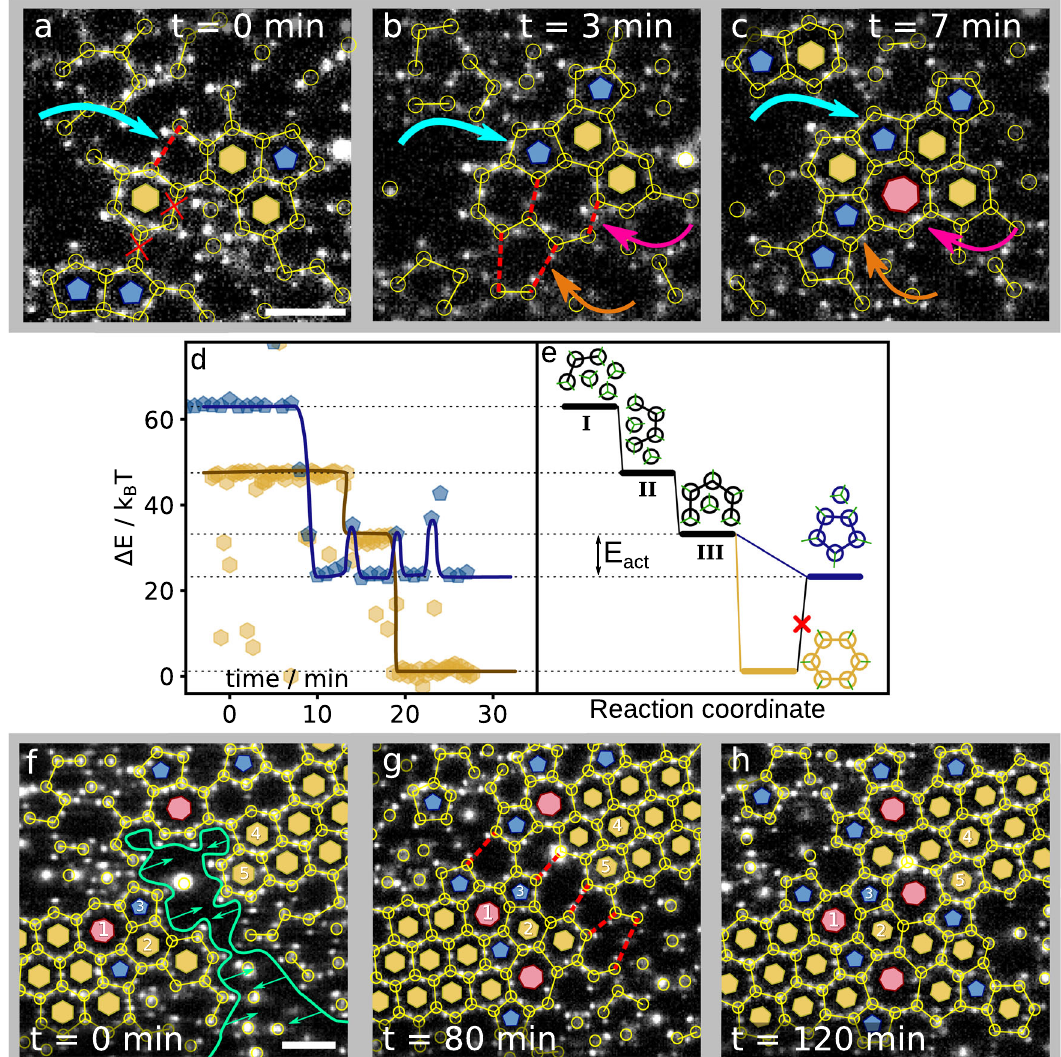
Fig. 3 | Origin of defects of colloidal graphene. a – c Annotated confocal micro- scopeimagesshowthespontaneousformationofagrainboundaryat Δ T =0.10°C, wherethehoneycombcrystalsarestillsmall.In( a ),twoparticlesareabouttobond at the red dotted line (blue arrow), forming a 5-membered ring. In ( b ), the 5-membered ring has formed, and promotes a neighbouring 7-membered ring (pink arrow). The 7-membered ring in turn promotes a 5-membered ring next to it (orange arrow). In ( c ), we show the fi nal structure that has grown spontaneously. d , e Energy-time traces of an isolated pentagon (blue) and hexagon (yellow) formingfromthreeandfourparticles,respectively.Theformerclosesimmediately into a 5-ring after addition of two particles and keeps trying to incorporate a sixth